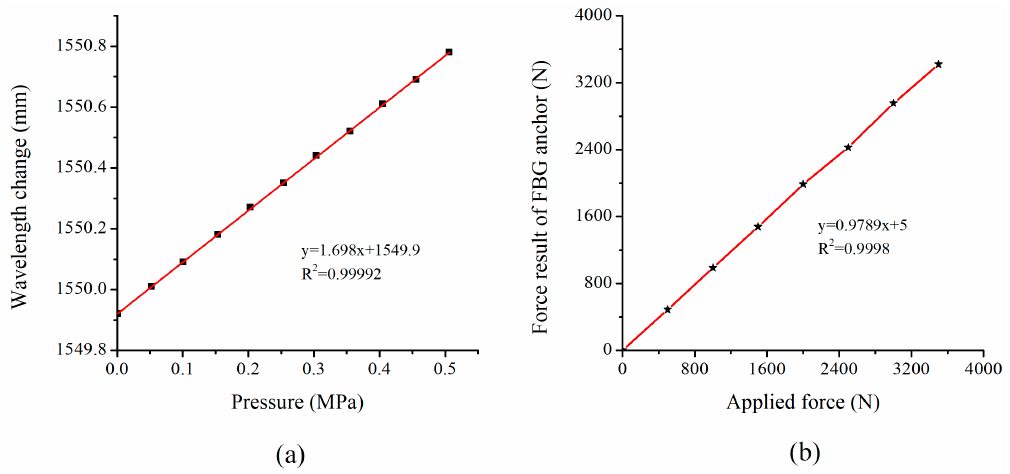
Figure 5. Calibration of FBG sensors ( a ) Calibration of earth pressure gauge ( b ) Calibration of FBG-based anchor.